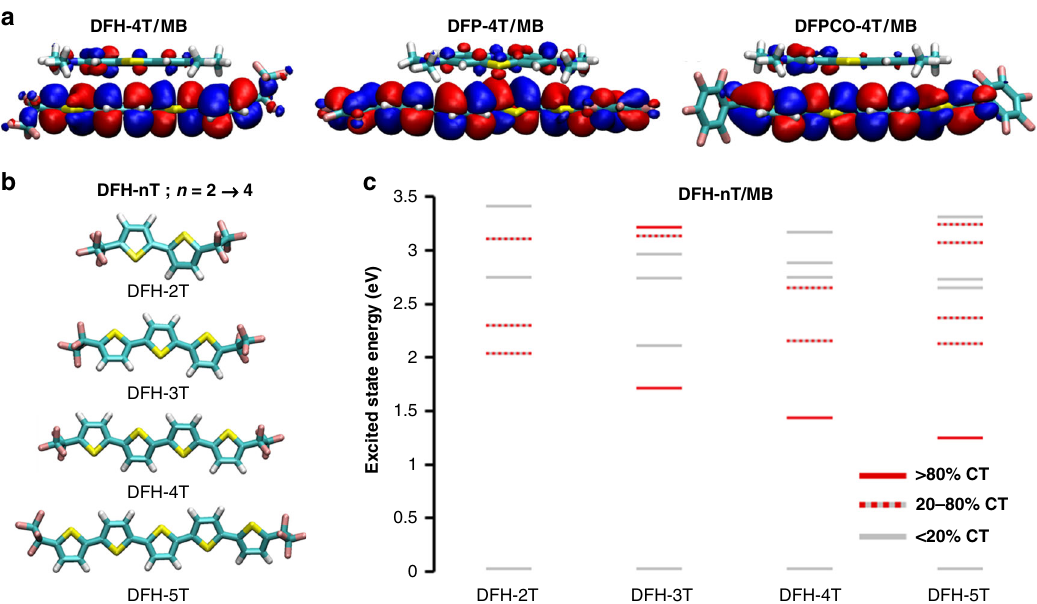
Fig. 5 Computational analysis. a Highest occupied molecular orbital (HOMO) topologies of the indicated semiconductor/MB at the INDO/SCI level. b Optimized geometries at the ω B97X-D/cc-pVTZ level of DFH - nT molecules studied to assess the effect of the π -backbone length. c Excited-state energies of DFH - nT /MB complexes as a function of the nT extension, computed at the INDO/SCI level. The color of each state indicates its charge-transfer (CT)